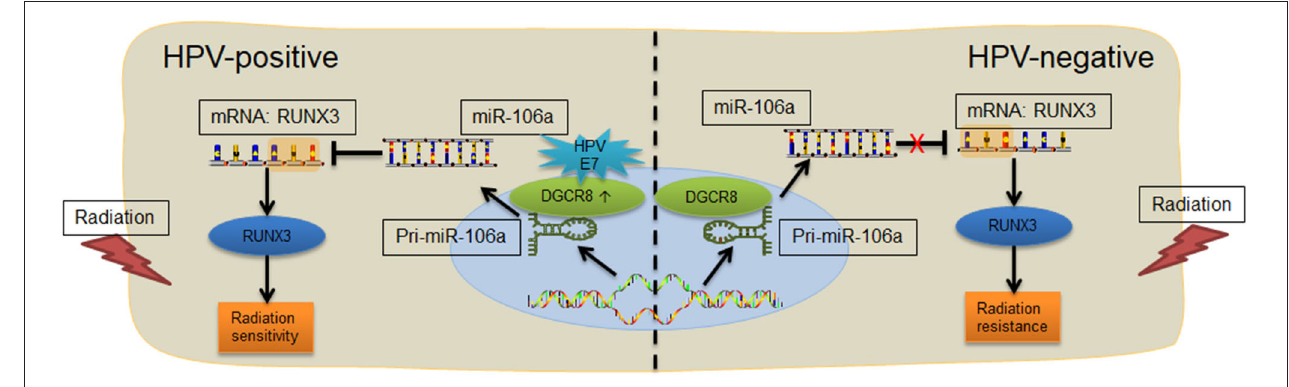
FIGURE 6 | Diagram of the E7/DGCR8/hsa-miR-106a axis enhances radiation sensitivity. Human papillomavirus (HPV)-positive head and neck squamous cell carcinoma (HNSCC) with high DGCR8 expression promoted the expression of miR-106a. The miR-106a suppressed RUNX3 mRNA expression via binding to the 3 ′ untranslated region (UTR) of RUNX3 and enhanced radiation